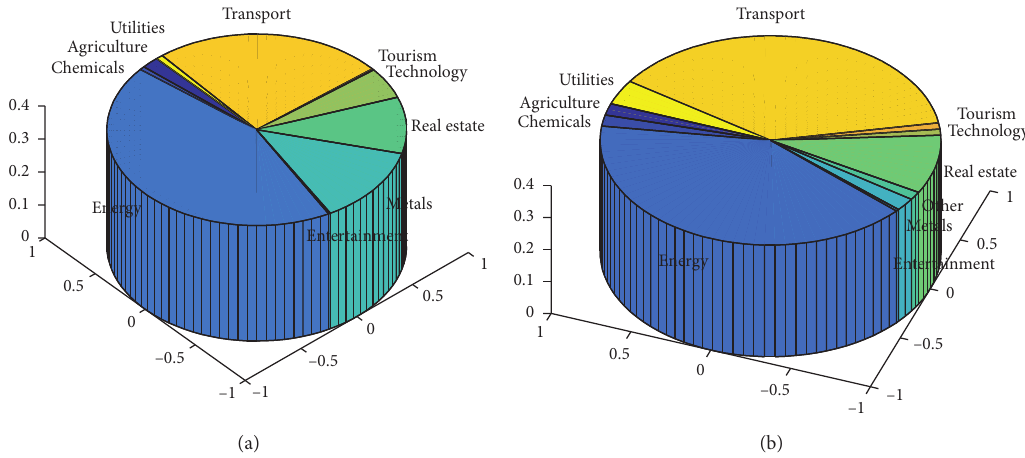
Figure 12: Sectors of China’s overseas construction projects (No. 3): (a) 2005–2007; (b) 2015–2017.